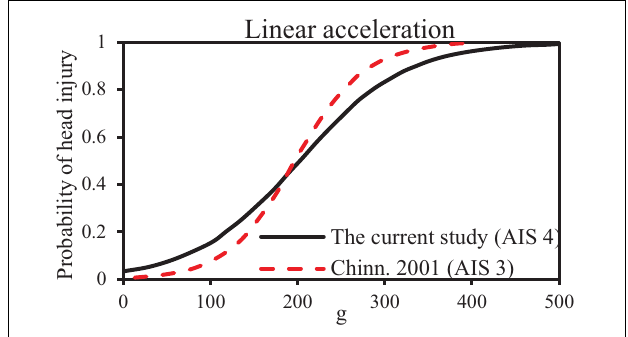
FIGURE 6 | Comparison of the linear acceleration risk curves for head injury.